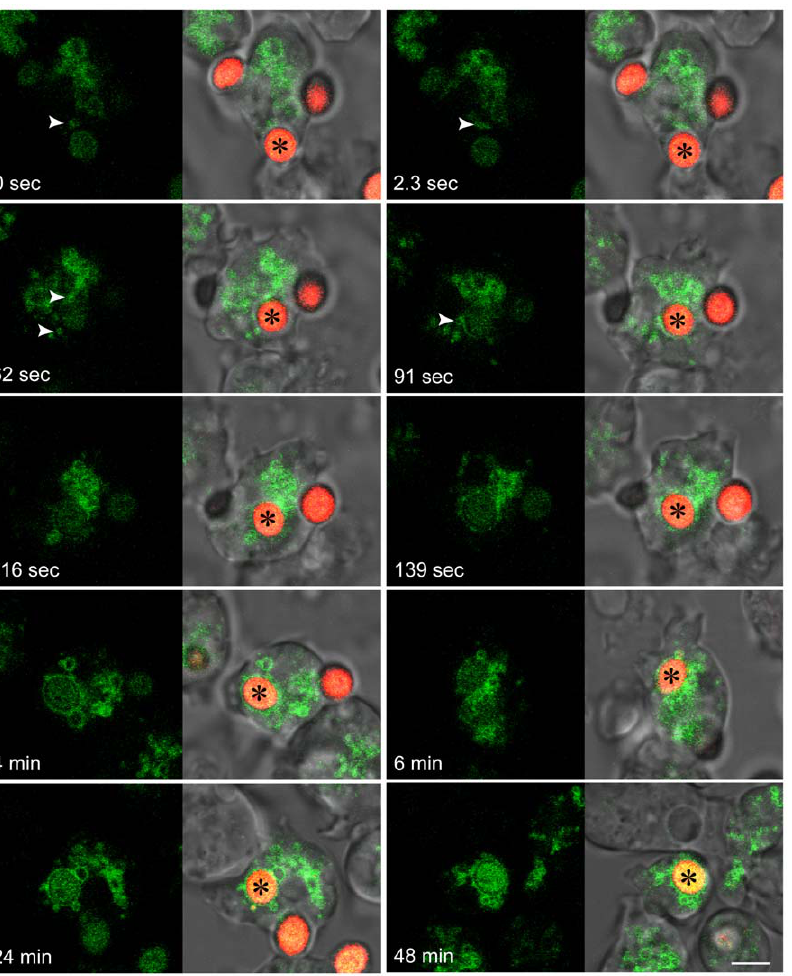
Figure 2. Recruitment of RpkA-GFP to the phagosomal membrane. Live cell analysis of TRITC-labeled S. cerevisiae uptake by AX2. Images were collected every 2.3 sec. Asterisks mark the yeast cell (red) which is taken up, arrowheads indicate RpkA-GFP containing vesicles (green) which are delivered to the maturing phagosome. Bar, 5 m m.